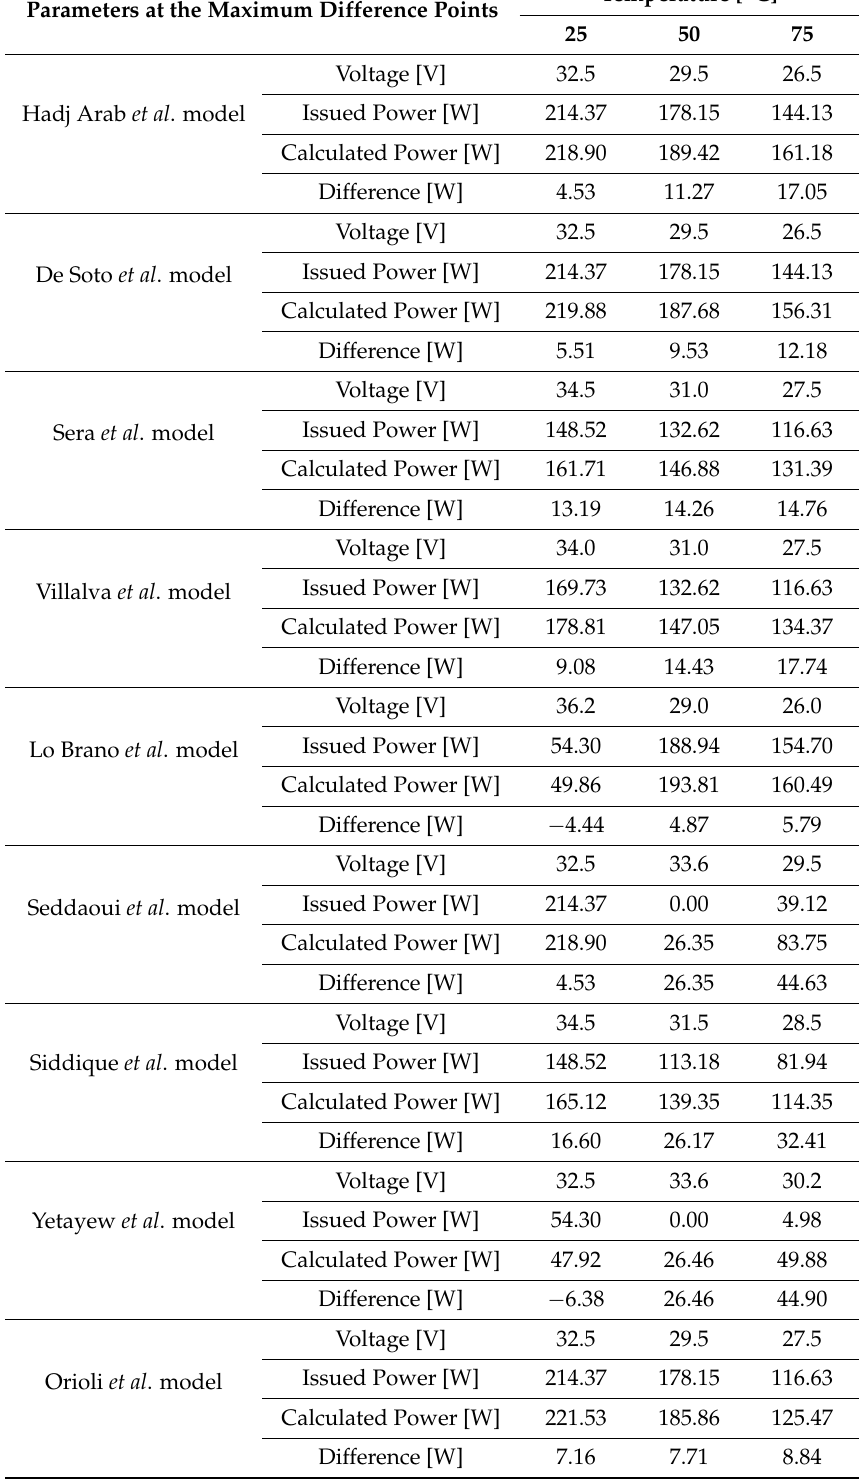
Table 13. Maximum power differences between the calculated and the issued I-V characteristics of Kyocera KD245GH-4FB2, at irradiance G = 1000 W/m 2 . Parameters at the Maximum Difference